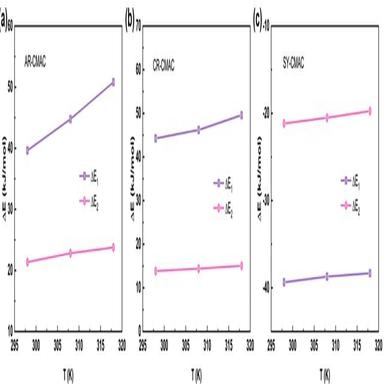
Calculated energetic parameters as function of temperature for AR, CR, and SY dyes adsorption on the CMAC composite.